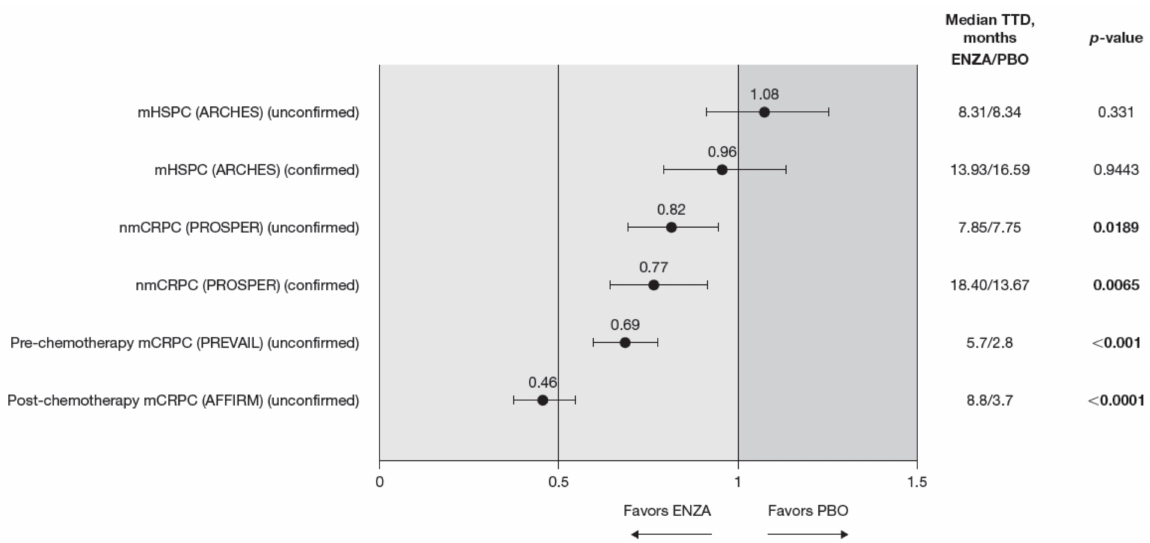
Figure 4. FACT-P PCS score TTD. To meet criteria for “confirmed” time to first deterioration, the initial (unconfirmed) report of deterioration had to be verified at the next consecutive study visit. Abbreviations: ENZA: Enzalutamide; FACT-P: Functional Assessment of Cancer Therapy—Prostate; mCRPC: Metastatic castration-resistant prostate cancer; mHSPC: Metastatic hormone-sensitive prostate cancer; nmCRPC: Non-metastatic castration-resistant prostate cancer; PBO: Placebo; PCS: Prostate Cancer Subscale of the FACT-P; TTD: Time to